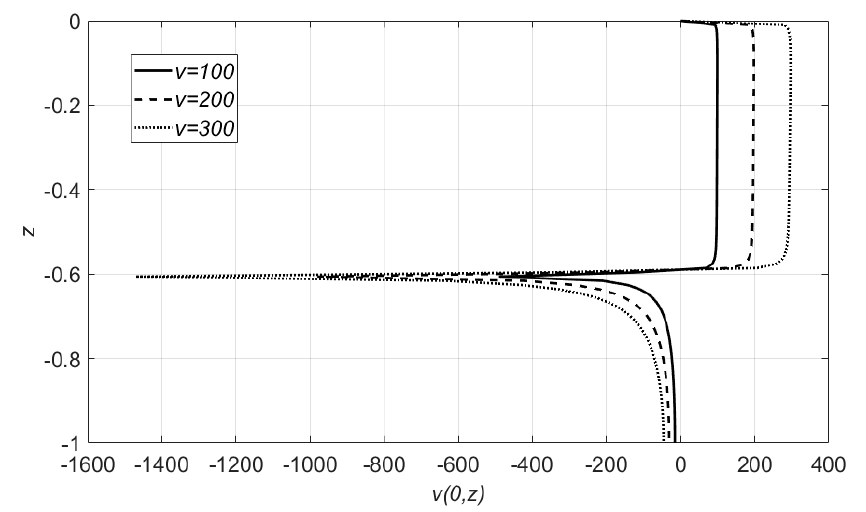
Figure 6. Wave impact velocity on the wall, v ( 0, z ) for fixed air cavity position − 1 ≤ z cavity ≤ − 0.6 and t = 0.01 s